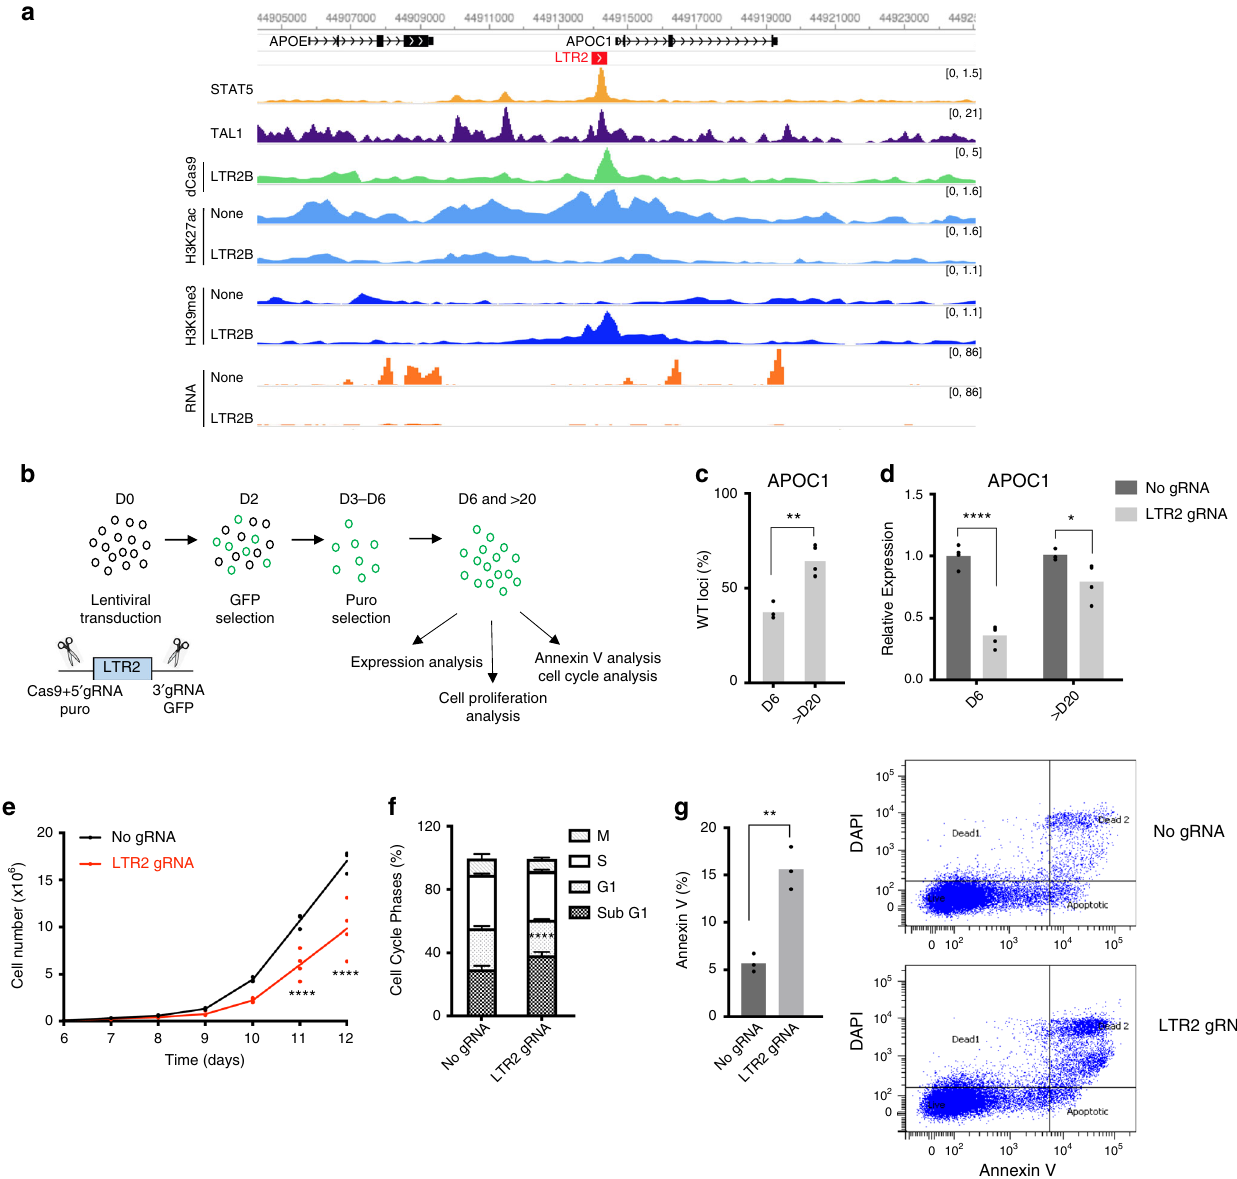
Fig. 6 APOC1 -LTR2 element promotes cell proliferation. a Genome browser snapshot for APOC1 -LTR2 element, showing TAL1, STAT5 ChIP-seq tracks for WT, H3K27ac, H3K9me3 ChIP-seq and RNA-seq tracks for no control and CRISPRi K562 cells. b Schematic of the experimental design to genetically excise APOC1 -LTR2 element. c qPCR data from cells with APOC1 -LTR2 excision ( n = 3 (D6) and n = 4 (>D20) biological replicates, bars represent mean value; two-tailed t test denotes ** p = 0.0036). d Expression data in the APOC1 -LTR2 excision cells (n = 4 (D6) and n = 3 (>D20) biological replicates, bars represent mean value; two-way ANOVA with Tukey ′ s multiple-comparison test, * p = 0.0312 and **** p < 0.0001). e Cell proliferation assay of control and APOC1 -LTR2-excised cells after puromycin selection (day 6). Data are from three independent experiments, one of which used two different APOC1 -LTR2 gRNA sets. **** p < 0.0001 (two-way ANOVA with Sidak ’ s multiple-comparison test). f Cell cycle pro fi les of control and APOC1 -LTR2-excised cells. Data are represented as mean ± SD ( n = 3 biological replicates, two-way ANOVA with Sidak ’ s multiple-comparison test, **** p < 0.0001). g % of Annexin V- stained cells in K562 cells upon APOC1 -LTR2 excision (left, n = 3 biological replicates, two-tailed t test, ** p = 0.0022). Representative fl ow cytometry analysis of Annexin V (right). Source data are provided as a Source Data fi le for ( c – g